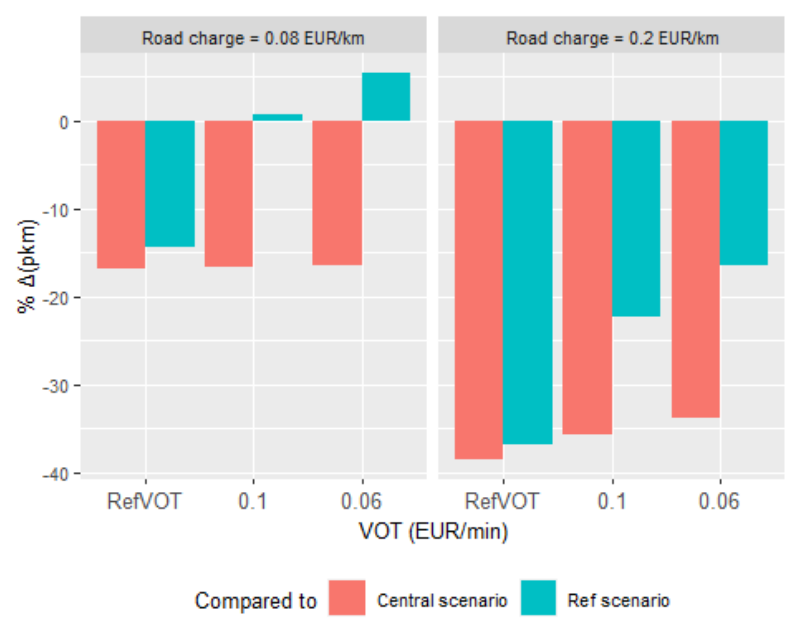
Figure 12. Road charge : changes in pkm compared to central and reference